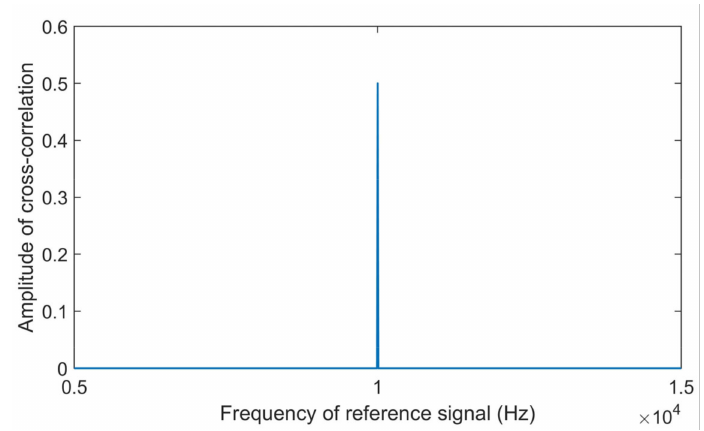
Figure 5. Cross-correlation spectrum ( N = 10,000 data